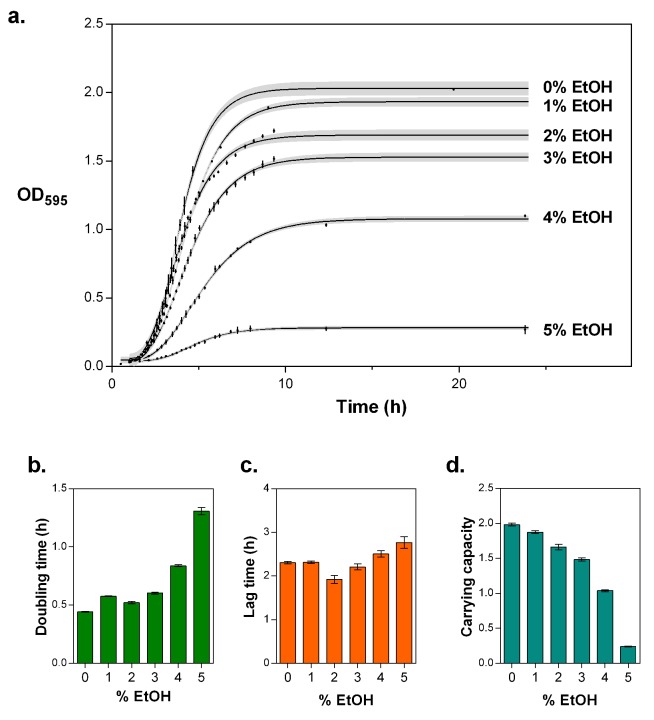
5% EtOH mimics near-lethal stress and leads to a severe decrease in growth rate and a decrease in carrying capacity.(a) Optical density as a function of time reflects growth dynamics and shows a rapid decrease in growth as the concentration of EtOH increases (mean ± s.d., n = 3, sigmoidal fit using Gompertz equation with 95% c.i. (shading), see Equation 1 in Materials and methods). (b) Doubling time for growth in increasing percentages of EtOH, calculated as the log10(2) divided by the specific growth rate obtained from the fittings (mean ± 95% c.i., n = 3). The doubling time triples at 5% EtOH mimicking near-lethal stress. (c) Lag time for growth in increasing percentages of EtOH (mean ± 95% c.i., n = 3). (d) Carrying capacity of the population for growth in increasing percentage of EtOH (mean ± 95% c.i., n = 3).